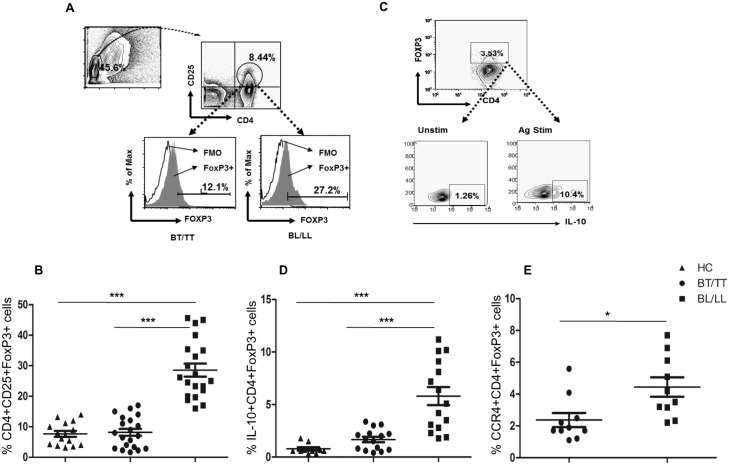
T regulatory cells in Leprosy.A) Representative FACS plot showing enumeration of Treg cell frequency (CD4+, CD25+ and FoxP3+) in BT/TT vs. BL/LL patient B) Total frequency of circulating Treg (CD4+, CD25+ and FoxP3+) cells in PBMCs isolated from peripheral blood of BT/TT vs. BL/LL patients (n = 20) vs. Healthy Contacts (n = 10). C) Representative flow cytometric analysis showing IL-10 production following in vitro stimulation with M. leprae (WCL) vs. unstimulated for 48 h in a Leprosy patient with LL. D) Scatter Plots are showing total IL-10 production in gated CD4+ FoxP3+ cells in BT/TT vs. BL/LL (n = 15) vs. Healthy Contacts (n = 10). E) CCR4 surface expression on gated CD4+ FoxP3+ cells in different groups of Leprosy patients (BT/TT vs. BL/LL), (n = 10). Each dot represents a single individual. Median values are shown in each set while P value< 0.05 was considered to be significant. Total number of cells analyzed by flow cytometry were 500,000. Data analysis was performed with flowjo software. Statistical analysis was done using Student’s t test for unpaired samples.